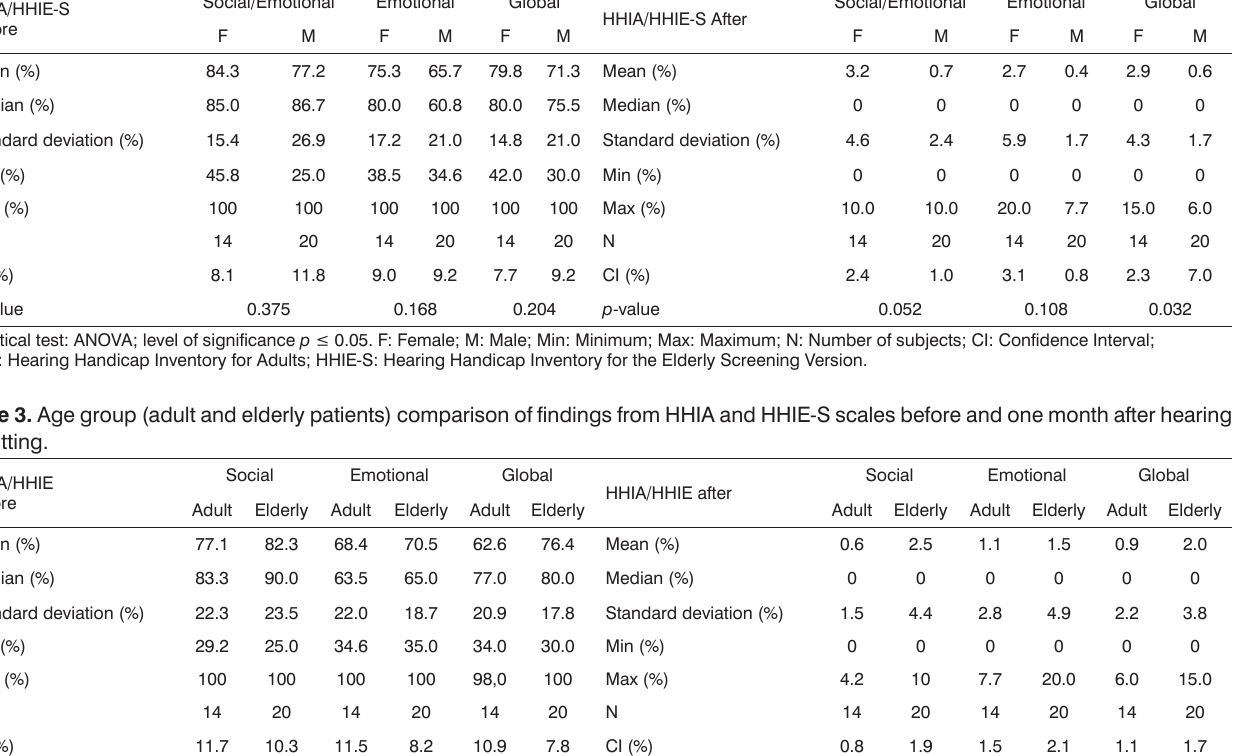
Table 2. Gender comparison of findings from HHIA and HHIE-S scales before and one month after hearing aid fitting. Social/Emotional Emotional Global HHIA/HHIE-S Before